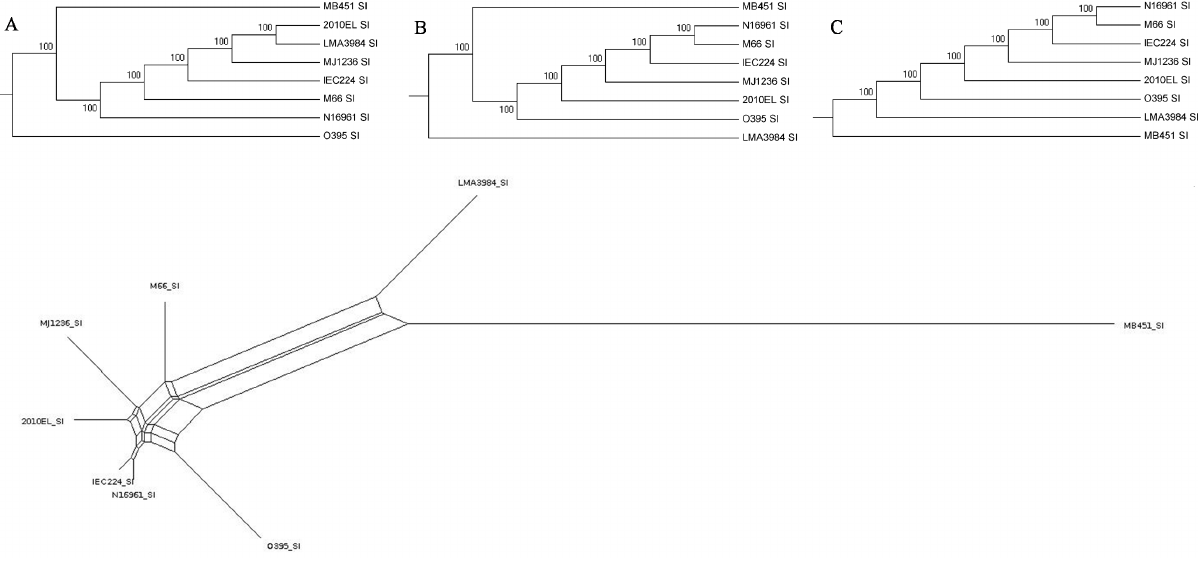
Figure 4. Top: Phylogenetic trees for the V. cholerae SI based on SNPs constructed by the Maximum Likelihood ( A ), Neighbor-Joining ( B ) and UPGMA ( C ) methods. The numbers indicate the bootstrap values. Bottom: Split network for gene content based on the 408 genes in seven V. cholerae and one V. mimicus genomes. The network was constructed with SplitsTree4 using the GeneContentDistance method 12